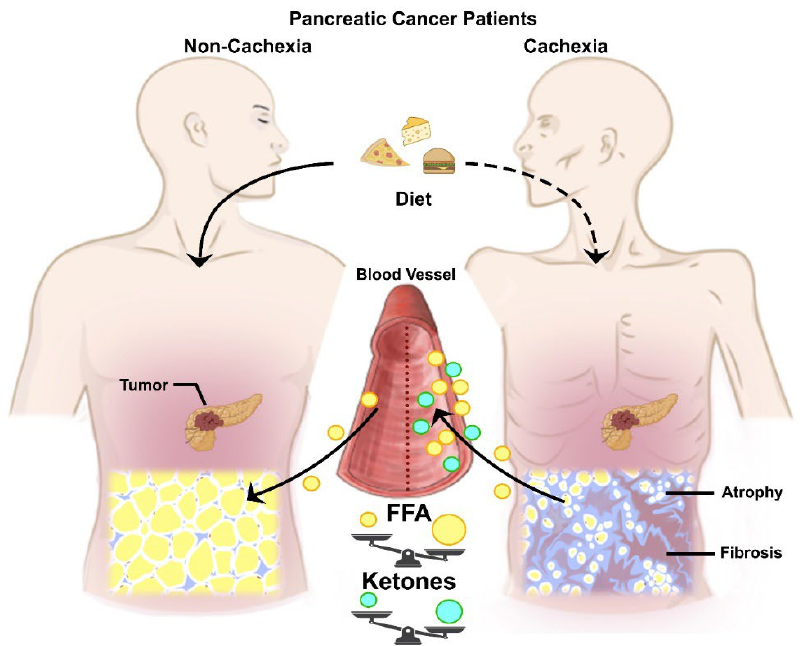
Figure 1. Schematic summary of altered fatty acid mobilization in pancreatic cancer patients with cachexia. Pancreatic cancer-related cachexia is primarily contributed by adipose tissue loss. Pancreatic cancer patients with cachexia appear to have lower dietary intake but have higher free fatty acid and ketone levels in circulation when compared to pancreatic cancer patients without adipose tissue wasting. Adipose atrophy is characterized by high infiltration of fibrosis and small size of adipocytes. Concomitantly, the fluorescent signal of peroxisome proliferator-activated receptor gamma (PPAR γ ), which is the well-known transcription factor for lipogenic genes including PLIN1 in adipocytes, darkens in cytoplasmic and nuclear parts of adipocytes in VAT from PDAC stage IV patients (Figure 2A). Thus, suppressed expression of perilipin-1 in